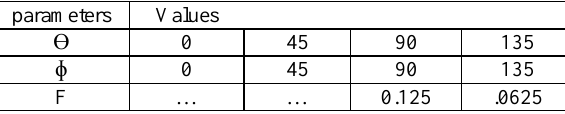
Table I. Parameters for 3D-Gabor